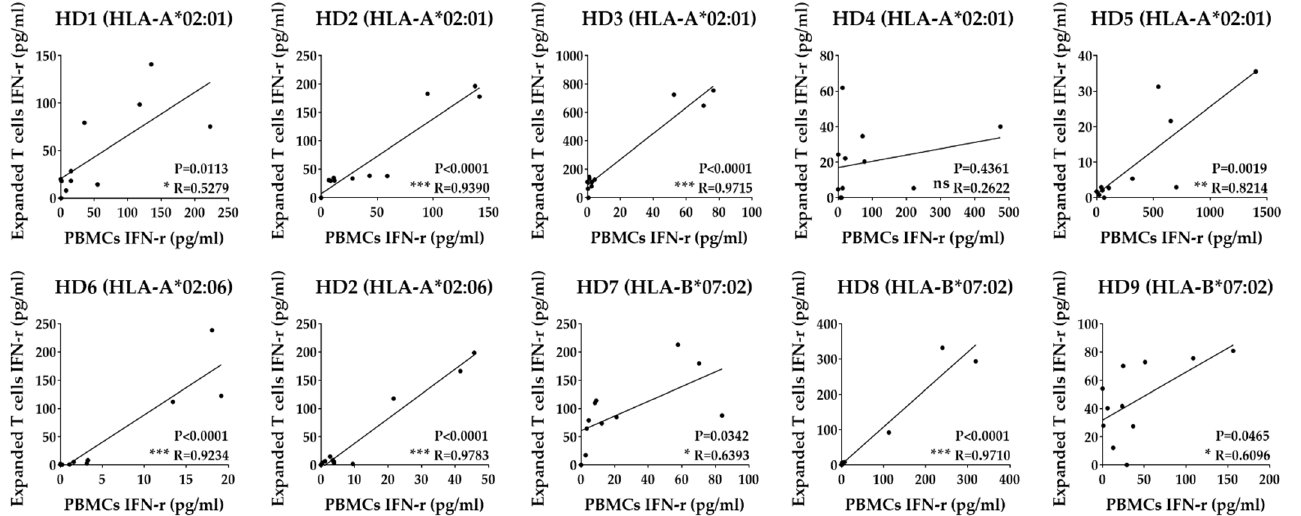
Figure 5. Correlation between T cell response to pp65 antigens by PBMCs and expanded T cells. Dots represent IFN-γ values secreted by PBMCs and expanded T cells specific for individual pp65 whole and fragment antigens. p value by two-tailed t -test and R value was calculated by Pearson’s correlation analysis. ns; p > 0.1, *; p < 0.05, **; p < 0.01, *** p < 0.001.